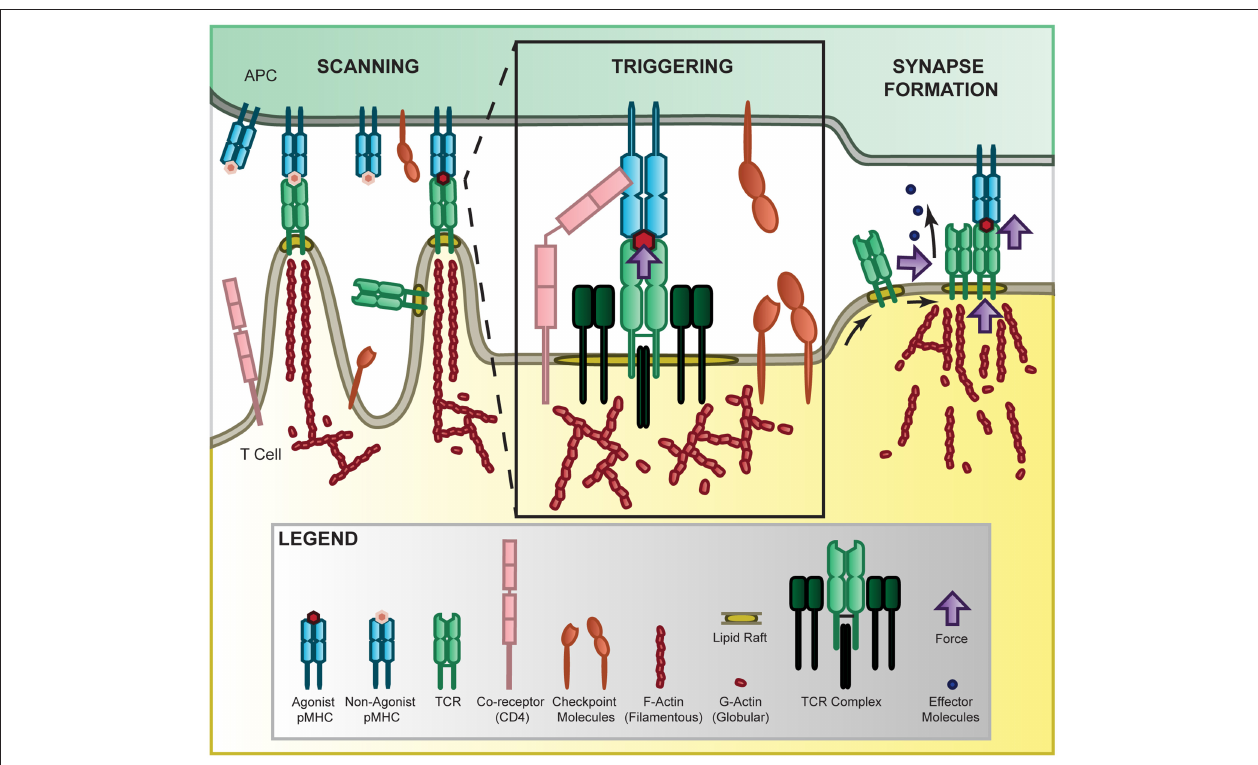
FIGURE 1 | Force in T-cell recognition. T cells scan APCs where they are able to sensitively discriminate activation cues from a large pool of non-activation cues by the TCR binding to MHC presenting self or non-self ligands [ 10–14]. The 2D agonist pMHC/TCR interaction is further mediated by co-receptor binding [19–22], checkpoint inhibition [23–25], and force through a catch-bond mechanism [11, 26–28]. Once sufficiently triggered, the TCR complexes accumulate together, sliding along the membrane in lipid rafts where they form microclusters and eventually the immunological synapse to localize internal signaling and release of effector molecules [14, 29–33]. This process is mediated by force through the cytoskeleton [34] where polymerizing actin provides tension in the microvilli that scan APC surfaces [35], at the membrane to stabilize the receptor and facilitate receptor sliding [36], and at the synapse to promote adhesion and release of effector